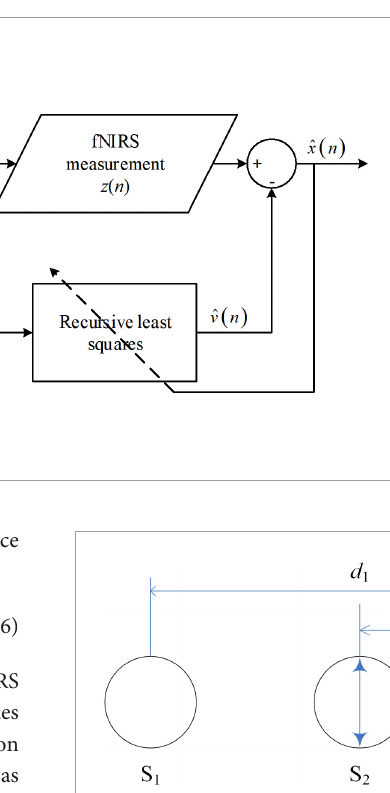
FIGURE3 Optode arrangement for multidistance optode arrangement